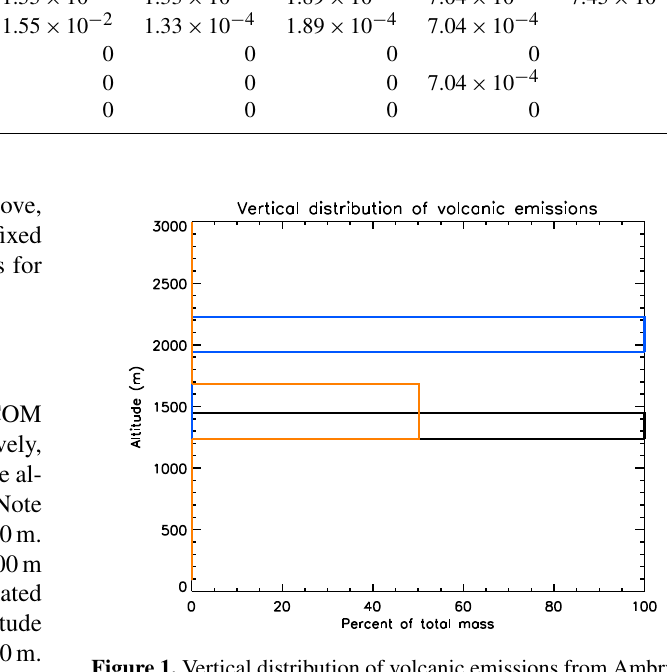
Figure 1. Vertical distribution of volcanic emissions from Ambrym as prescribed in the model for the all the simulations (black line) except for the sensitivity simulations S1_HighT_alt (blue line) and S1_HighT_width (orange line). See Sect. 2.3.4 for details on simu-